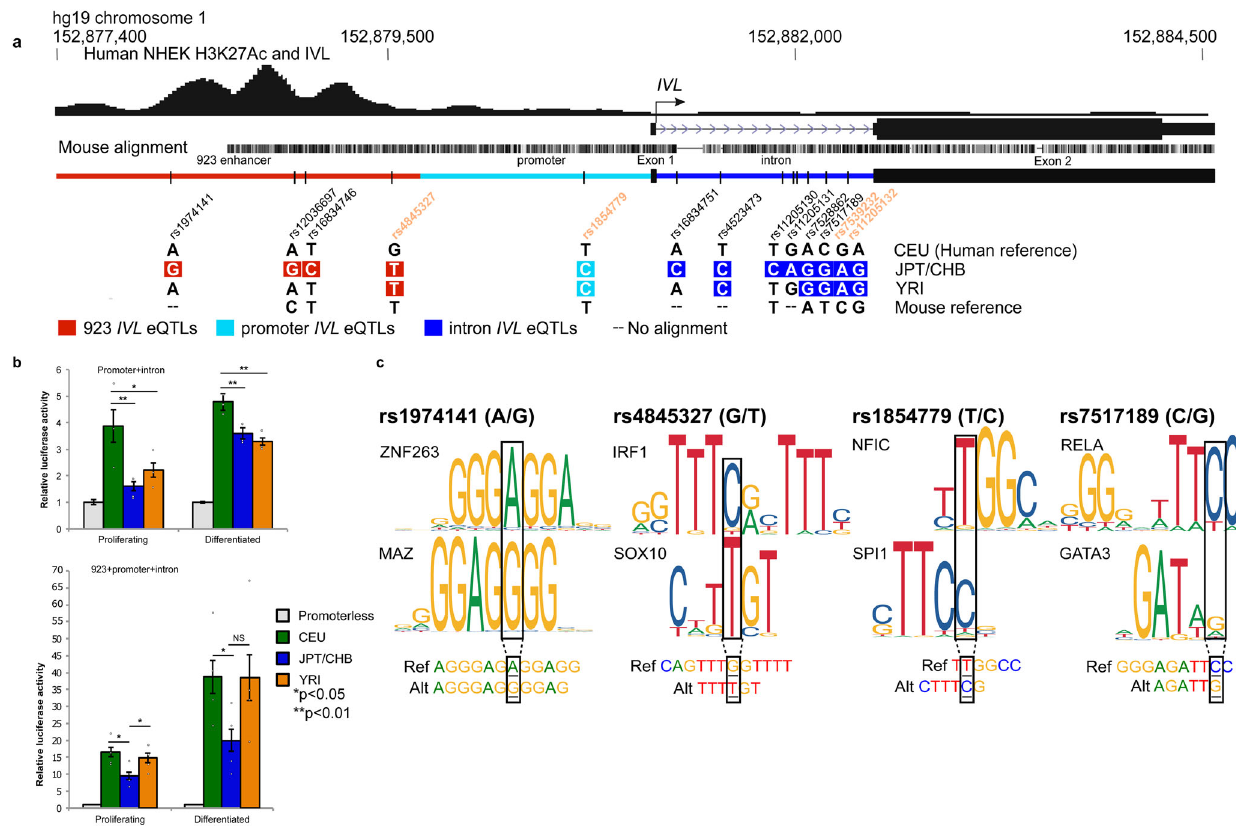
Fig. 4 Population-speci fi c 923 enhancer: IVL promoter/intron alleles and eQTLs impact regulatory activity. a Schematic of population-speci fi c human 923 enhancer (red), IVL promoter (light blue), 1st exon, and intron (dark blue) alleles with IVL eQTLs. Positions of variants not to scale. Colored boxed variants are associated with relatively lower IVL expression levels to human reference. Positively selected iSAFE SNPs for CEU in orange. b Luciferase assays of population-speci fi c alleles for the IVL promoter/intron + respective enhancer reveals that the CEU promoter/intron allele has the highest regulatory activity (Proliferating: p = 0.003 vs. JPT/CHB; p = 0.025 vs. YRI; Differentiated: p = 0.008 vs. JPT/CHB; p = 0.001 vs. YRI). The addition of the enhancer confers higher reporter expression with more activity in CEU ( p = 0.003) and YRI ( p = 0.024) than JPT/CHB and especially in differentiated cells for CEU vs. JPT/CHB ( p = 0.047). Mean ± SEM of n independent experiments ( n = 3, IVL promoter/intron) and ( n = 4, 923 enhancer + IVL promoter/ intron), one-way ANOVA followed by Tukey ’ s HSD. c Position weight matrices (PWM) for candidate transcription factor binding motifs in reference and alternate alleles at rs1974141, rs4845327, rs1854779, & rs7517189 associated with population-speci fi c regulatory activity. Strand sequence with SNP included for comparison to